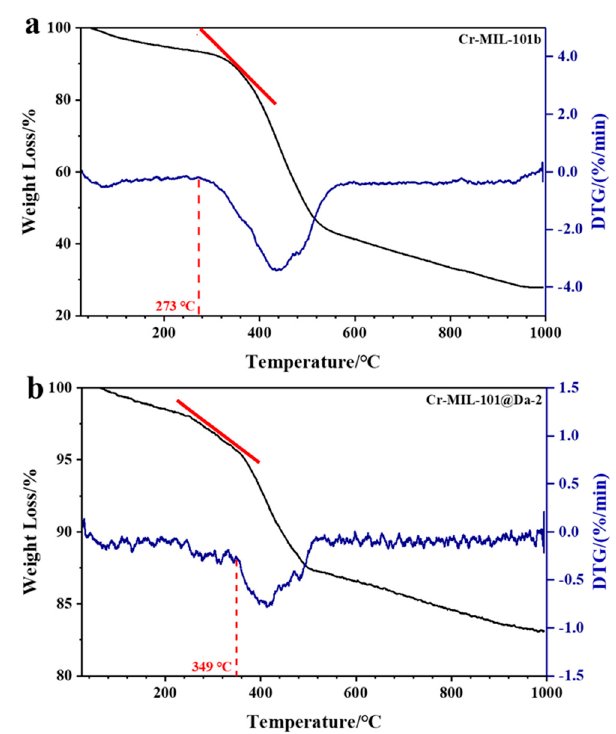
Figure 8. TG-DTG curves of ( a ) Cr-MIL-101b and ( b ) Cr-MIL-101@Da-2. Red tangent lines highlight the respective slope(s) and different weight loss rates for MOF-Da composites. Table 3. Decomposition temperatures for Cr-MIL-101 and The hydrolytic stability of Cr-MIL-101@Da is demonstrated by PXRD patterns before and after alternate exposure to 98% RH and 33% RH water vapor cycling every 12 h at 318 K for over one